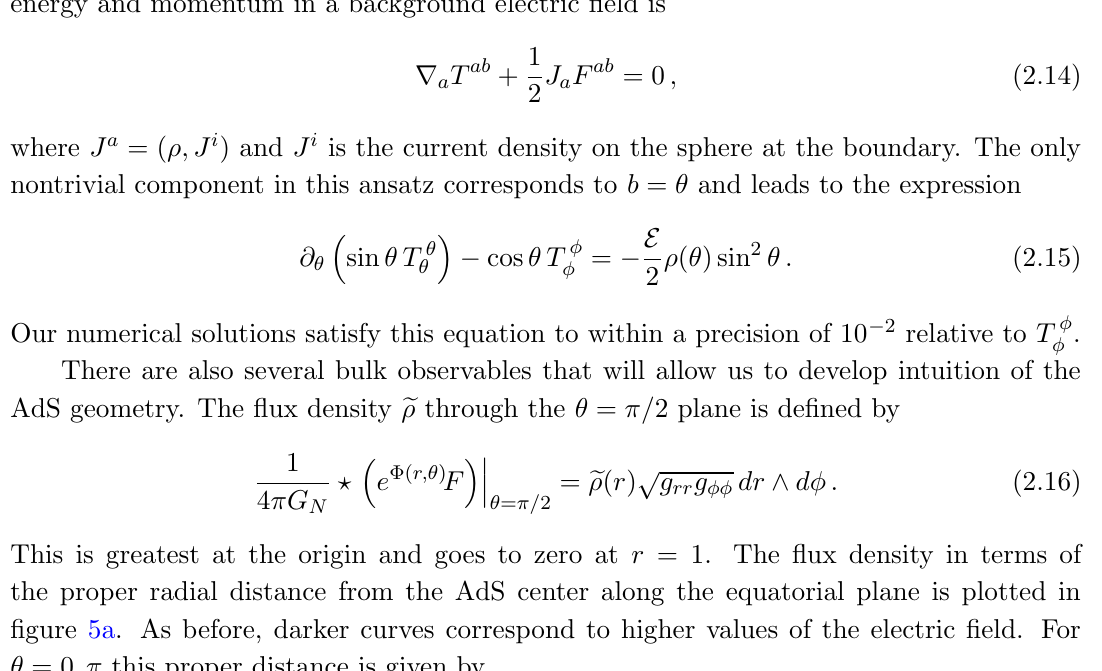
Sol [0 ; ]. We set G N = c E 2 E